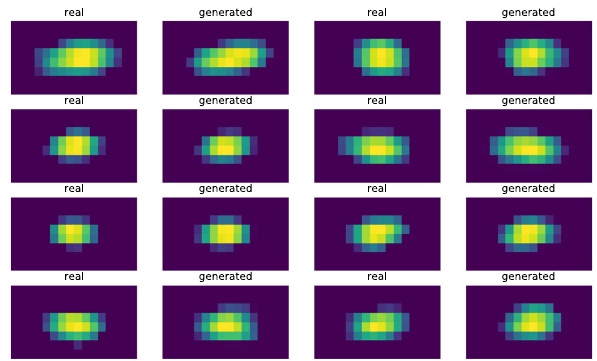
Fig. 1 Examples of the generated pad responses. Vertical and horizon- tal axes correspond to the pad and time bins, respectively. Each image from the validation dataset (1st and 3rd columns) is paired up with a generated image (2nd and 4th columns) obtained for the same values of the conditional variables